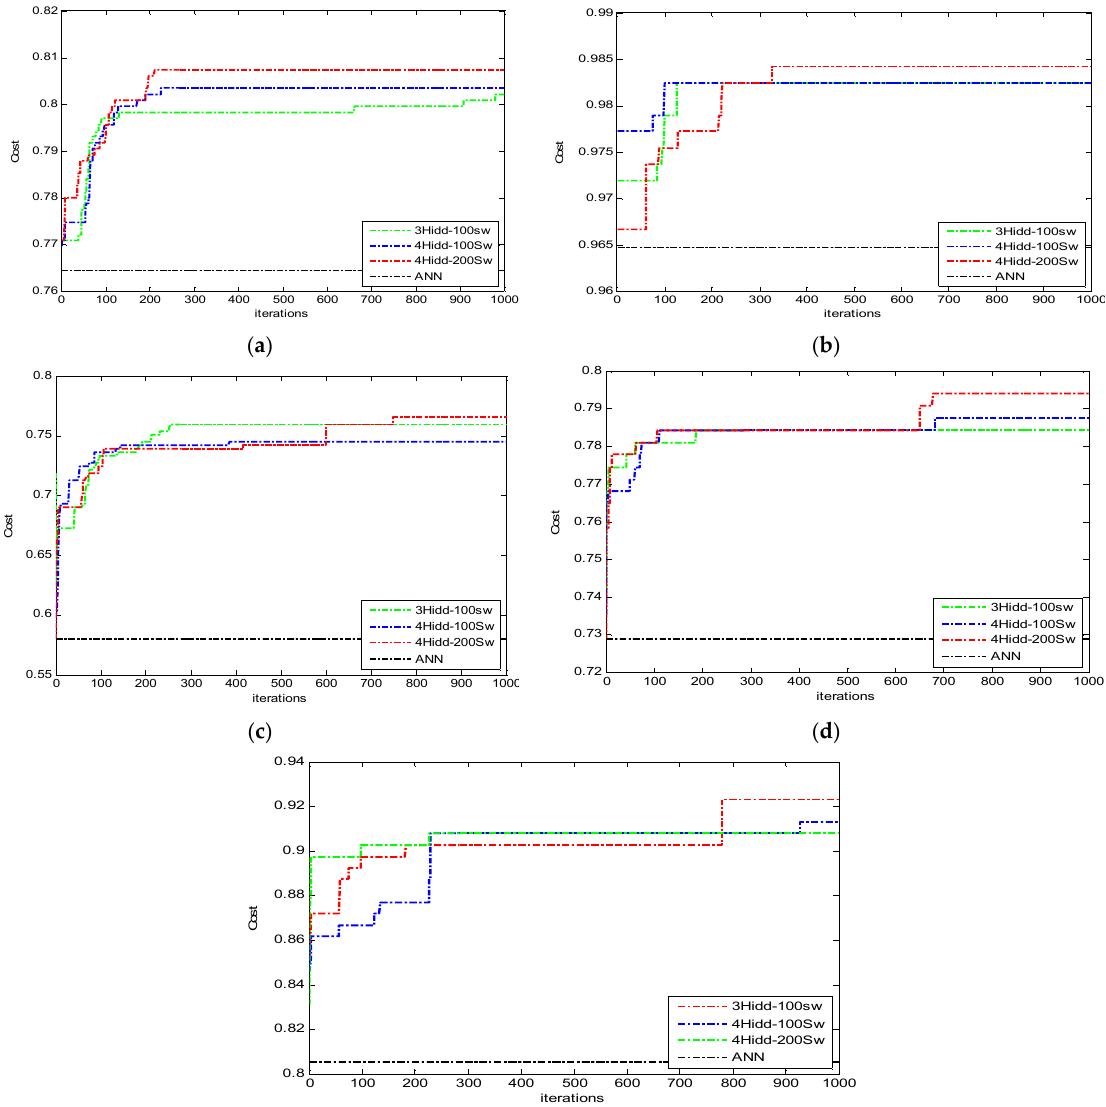
Figure 6. The performances of PSO with four hidden layers using 1000 iterations and 200 swarms (PSO population) applied on the five disease data sets: ( a ) PID; ( b ) WDBC; ( c ) LD; ( d ) HSS; ( e ) PD.